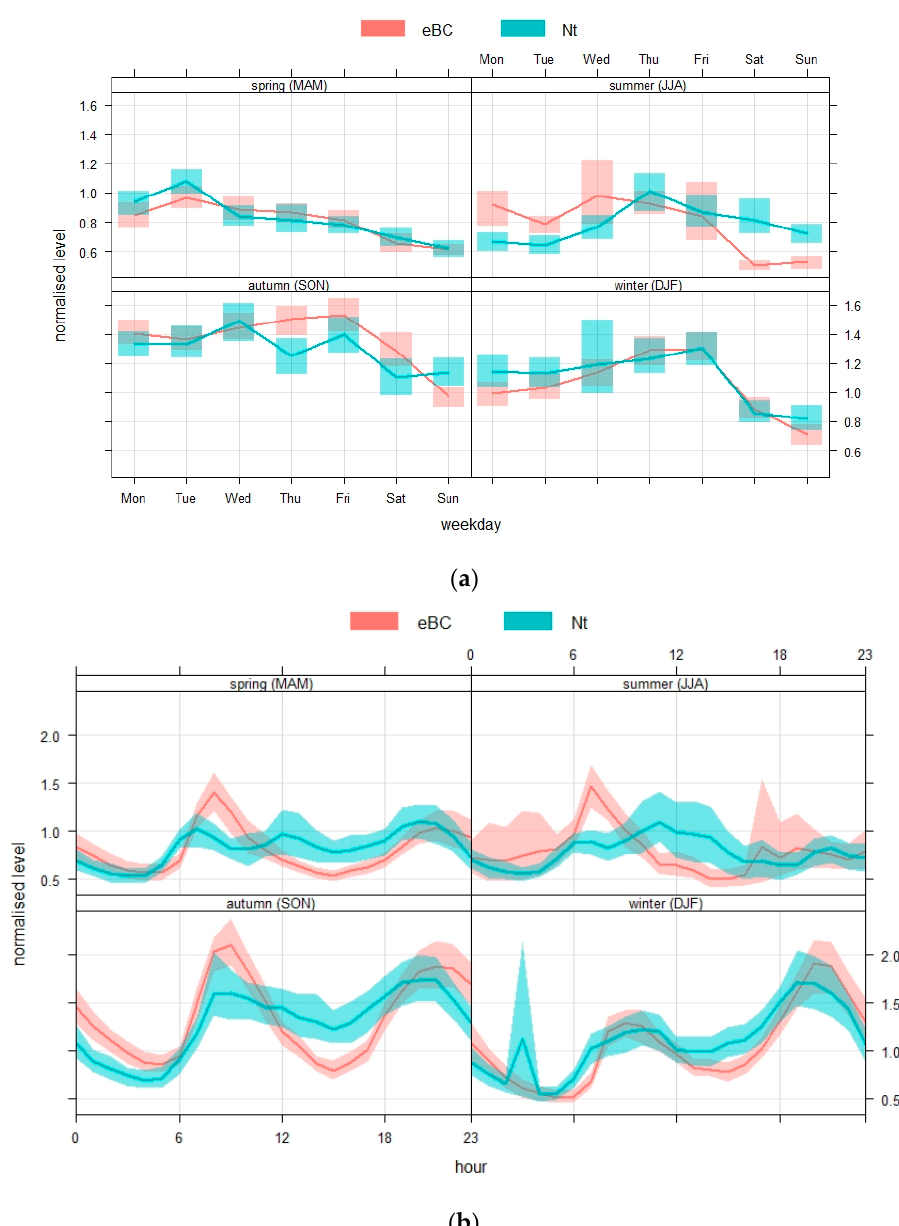
Figure 6. ( a ) Day of the week variation of eBC (µg m − 3 ) and total number of particles (Nt) (particles cm − 3 ) normalized concentrations (variable (s) are divided by their mean values; this helps to compare the shape of the trends for these two variables with different scales). ( b ) Hour of day variation of eBC (µg m − 3 ) and Nt (particles cm − 3 ) normalized concentrations. The shaded area represents the range of values in which 95% of sample means lie.